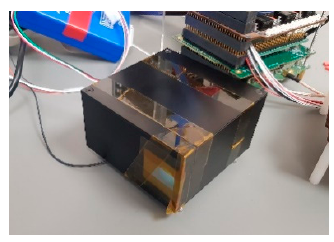
Figure 1. The Argus 2000 Spectrometer.